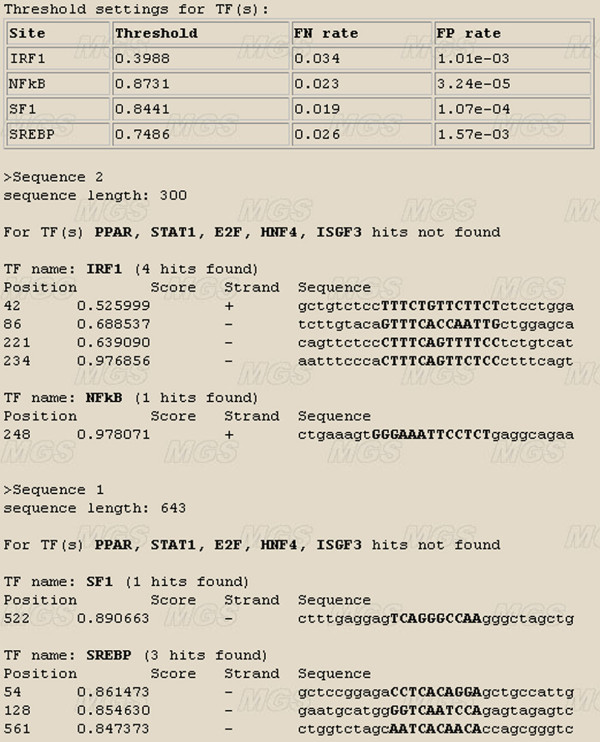
Example of the SiteGA tool output data.